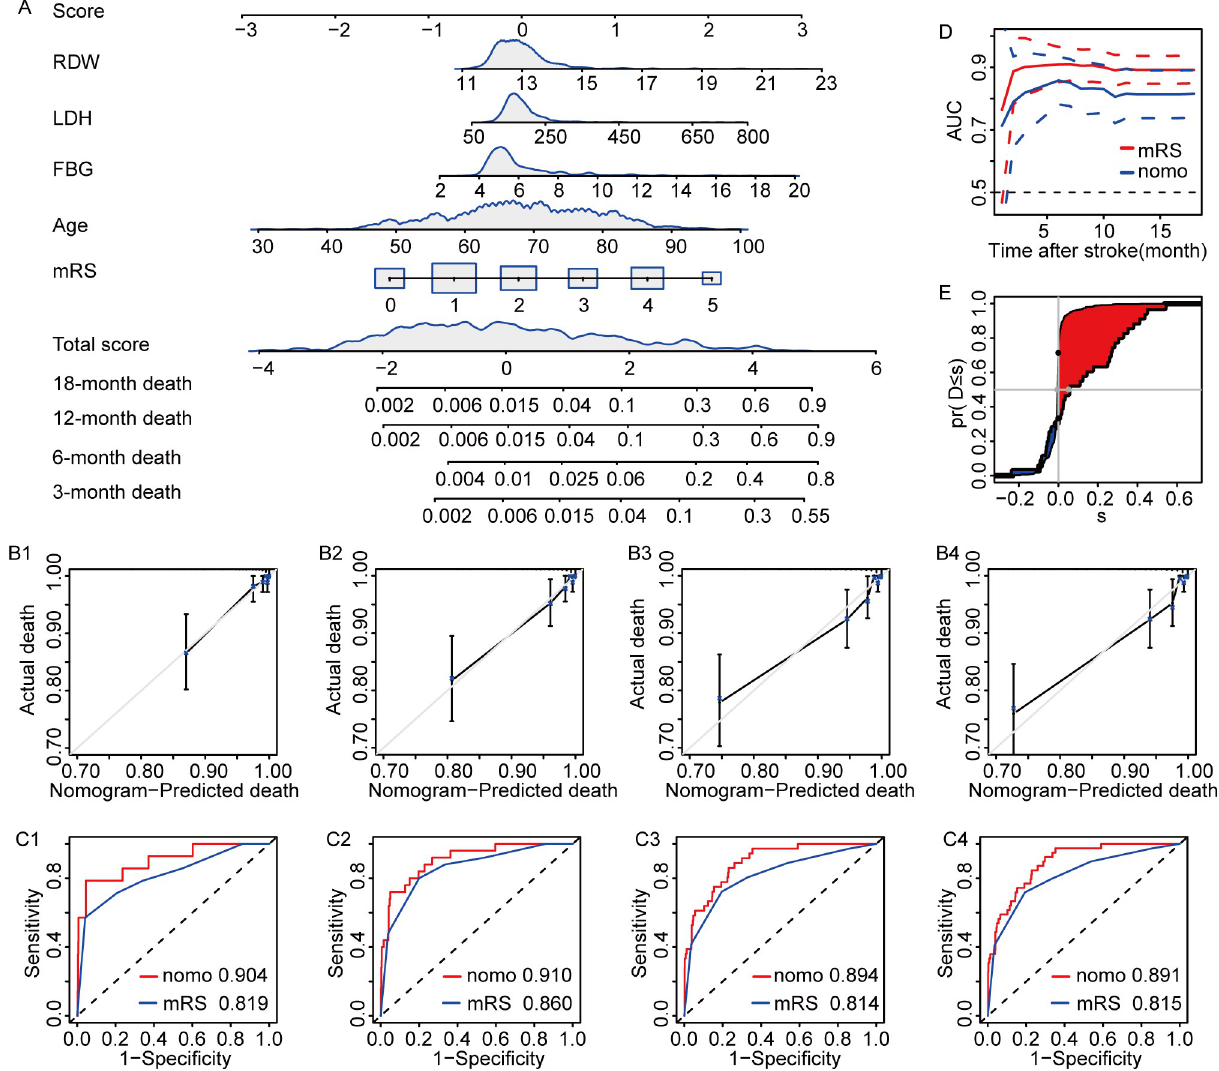
Fig 7. The models for predicting death probability in AIS patients. A. Nomogram for predicting death probability in AIS patients; B. The calibration curves based on nomogram prediction and actual observation at 3-month(B1), 6-month(B2), 12-month(B3), 18-month(B4); C. Time-dependent ROC curves to evaluate the accuracy of the nomogram at 3-month(C1), 6-month(C2), 12-month(C3), 18-month(C4); D. Time-dependent ROC curves to evaluate the accuracy of the nomogram. E. NRI and IDI to evaluate the accuracy between the nomogram and the mRS score.